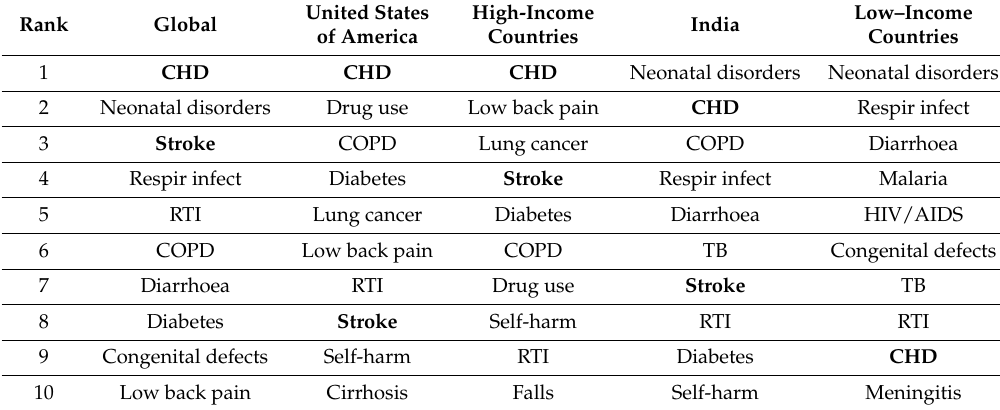
Table 4. The 10 most common causes of disability-adjusted life-years lost in men, globally and in selected countries and regions,